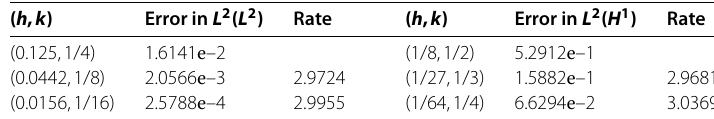
Table 8 The errors and convergence rates of v – v hk in the L 2 ( L 2 ) and L 2 ( H 1 )